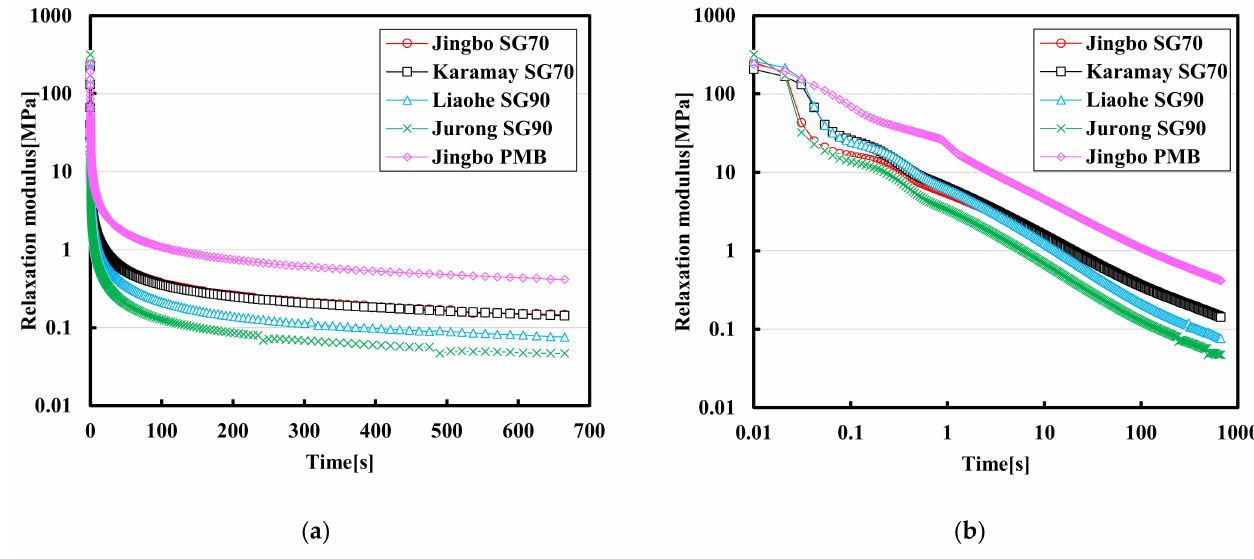
Figure 7. Modulus relaxation curves of semi-log scale ( a ) and log-log scale ( b ) of five hydraulic bitumen binders at − 10 ◦